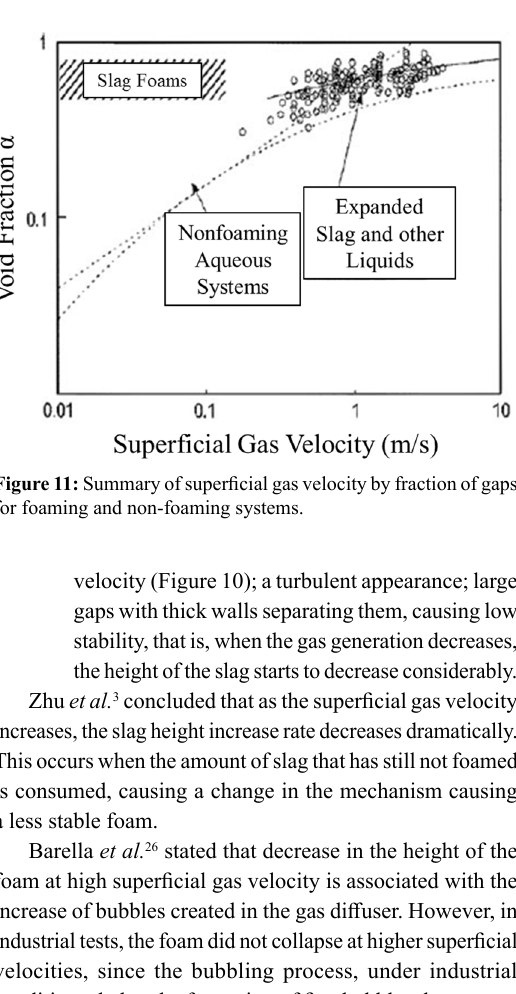
velocity (Figure 10); a turbulent appearance; large gaps with thick walls separating them, causing low stability, that is, when the gas generation decreases, the height of the slag starts to decrease